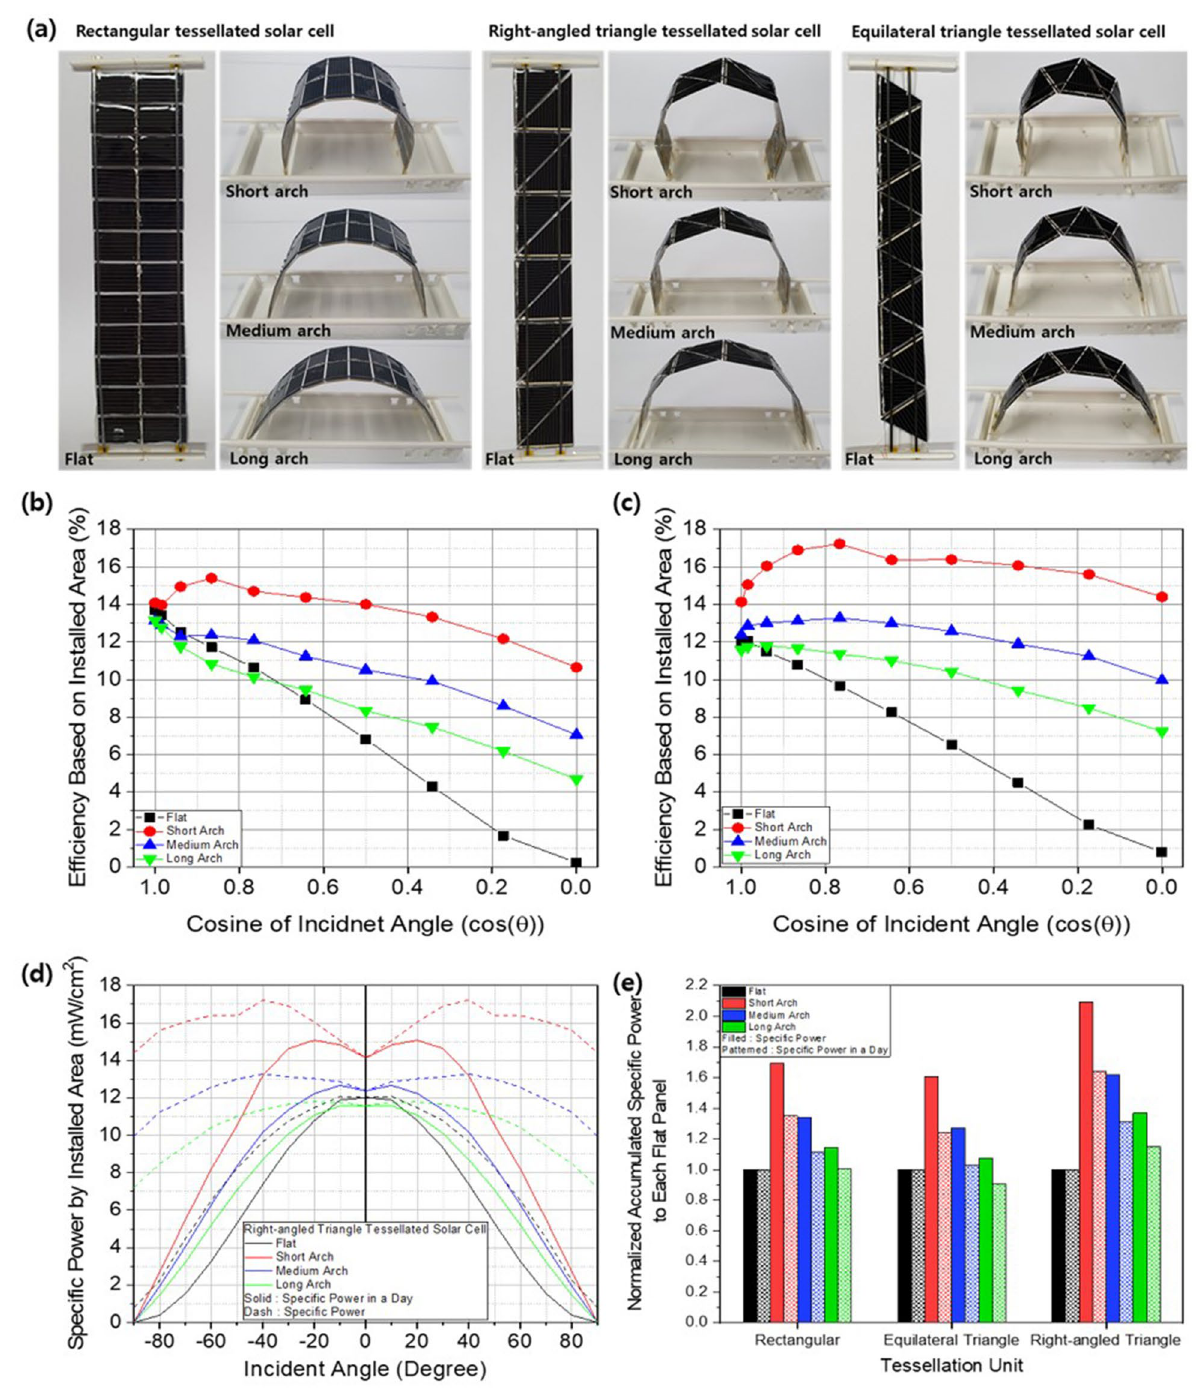
Figure 5. ( a ) Photographs of rectangular, right-angled and equilateral-triangle-shaped tessellated solar cells in flat and various 2D arch states in a restricted installation area. Efficiency based on installed area of arches comprised of ( b ) rectangular and ( c ) right-angled-triangle 2D tessellated solar cells. ( d ) Rectangular 2D tessellated solar cell’s accumulated power and power over a day and ( e ) relative accumulated power and power over a day compared according to a restricted installation area for flat and various 2D arch